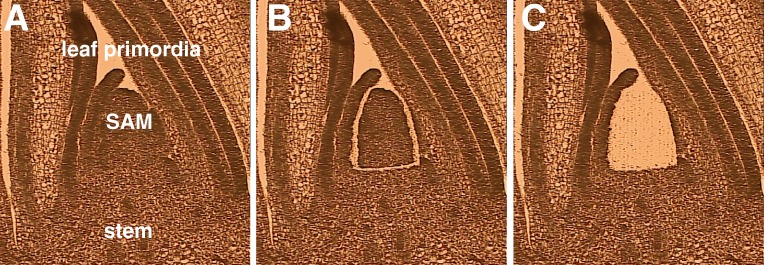
LM of the SAM from Paraffin Sections of Maize Seedlings(A) The apex before LM is shown.(B) Laser ablation is used to isolate the SAM from surrounding leaf primordia and stem tissue, without heating or damaging adjacent SAM tissues.(C) SAM tissue is microdissected via laser pressure catapulting, in which the laser is focused beneath the targeted SAM tissue and a high photonic force catapults the tissue into a collection tube suspended above the sample.